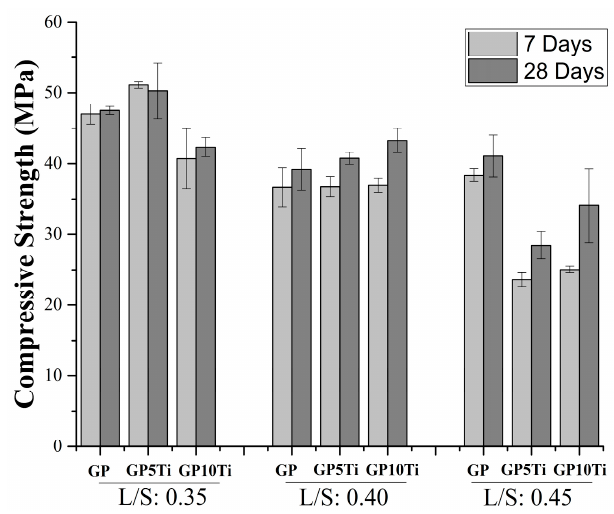
Figure 7. Compressive strength of the various materials evaluated.